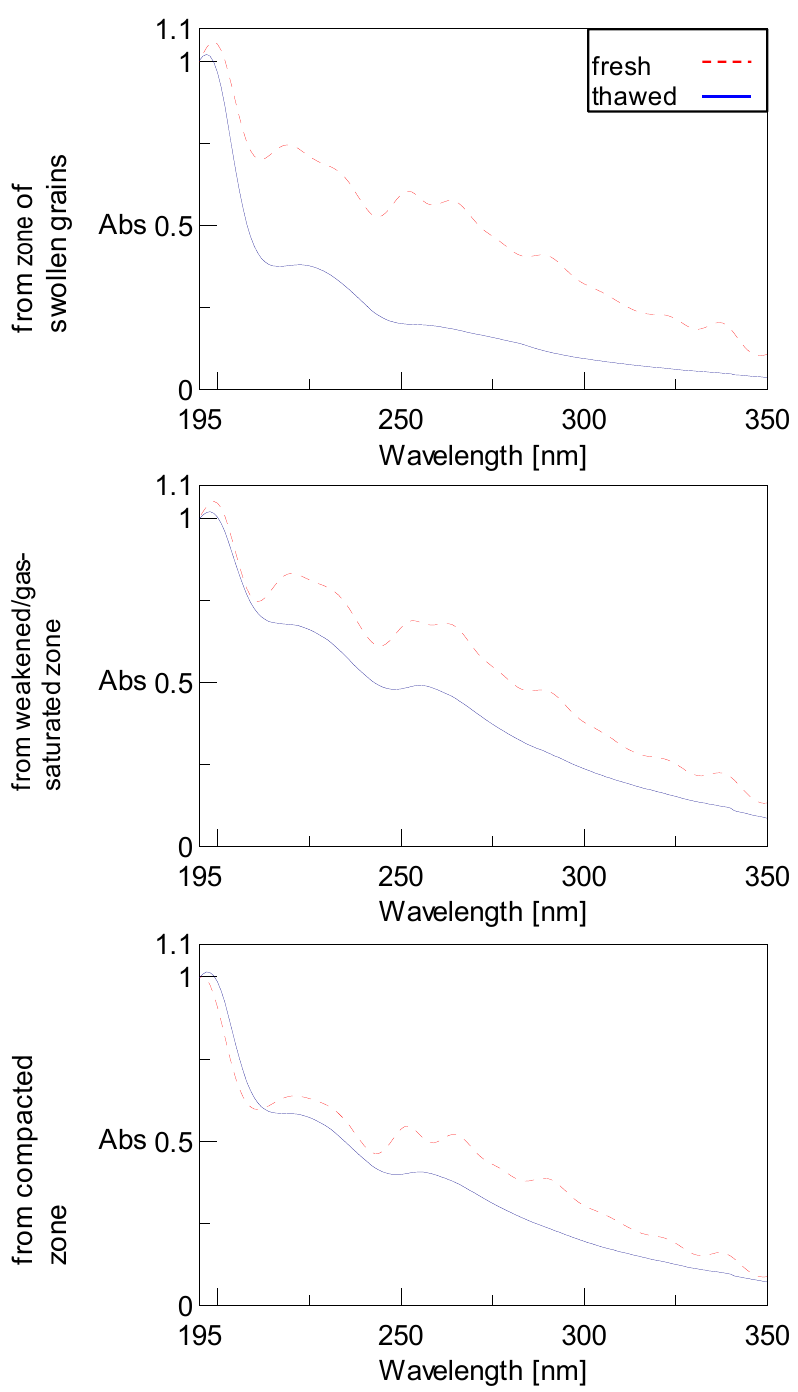
Figure 4. The UV spectra of the extracts from the zones of coal plastic layer: swollen grains, weakened/gas ‐ saturated zone, compacted zone.